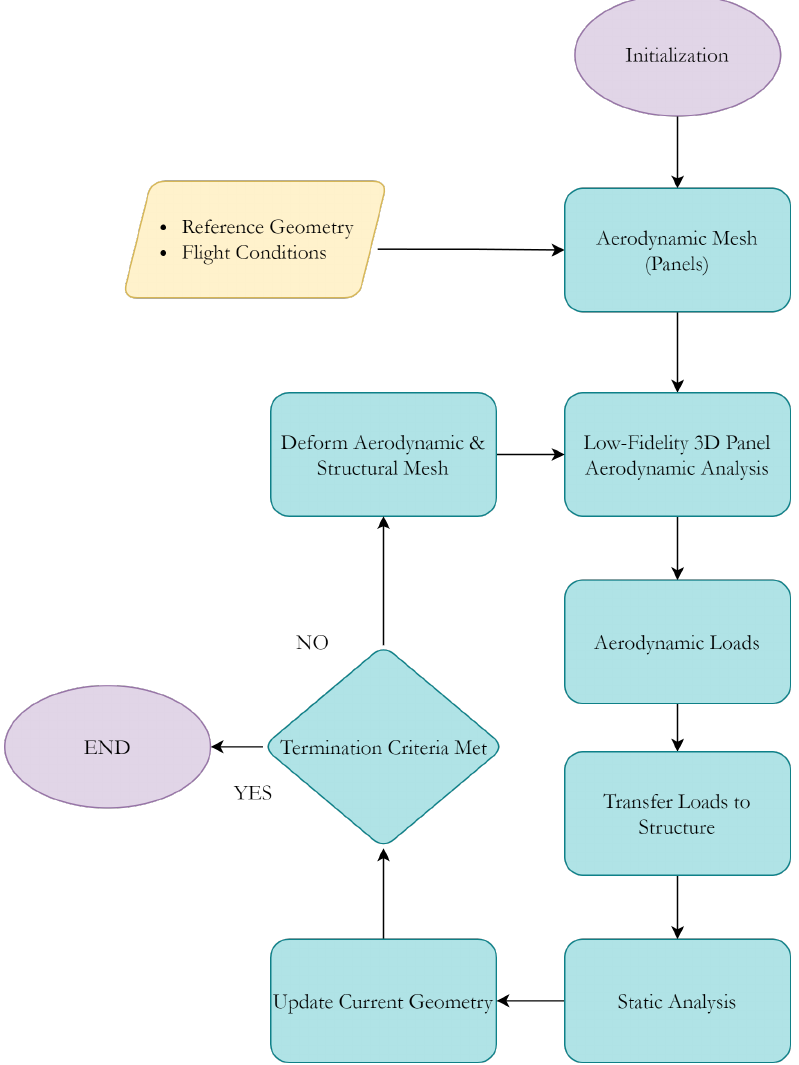
Figure 1. 3D-panel-method staggered FSI